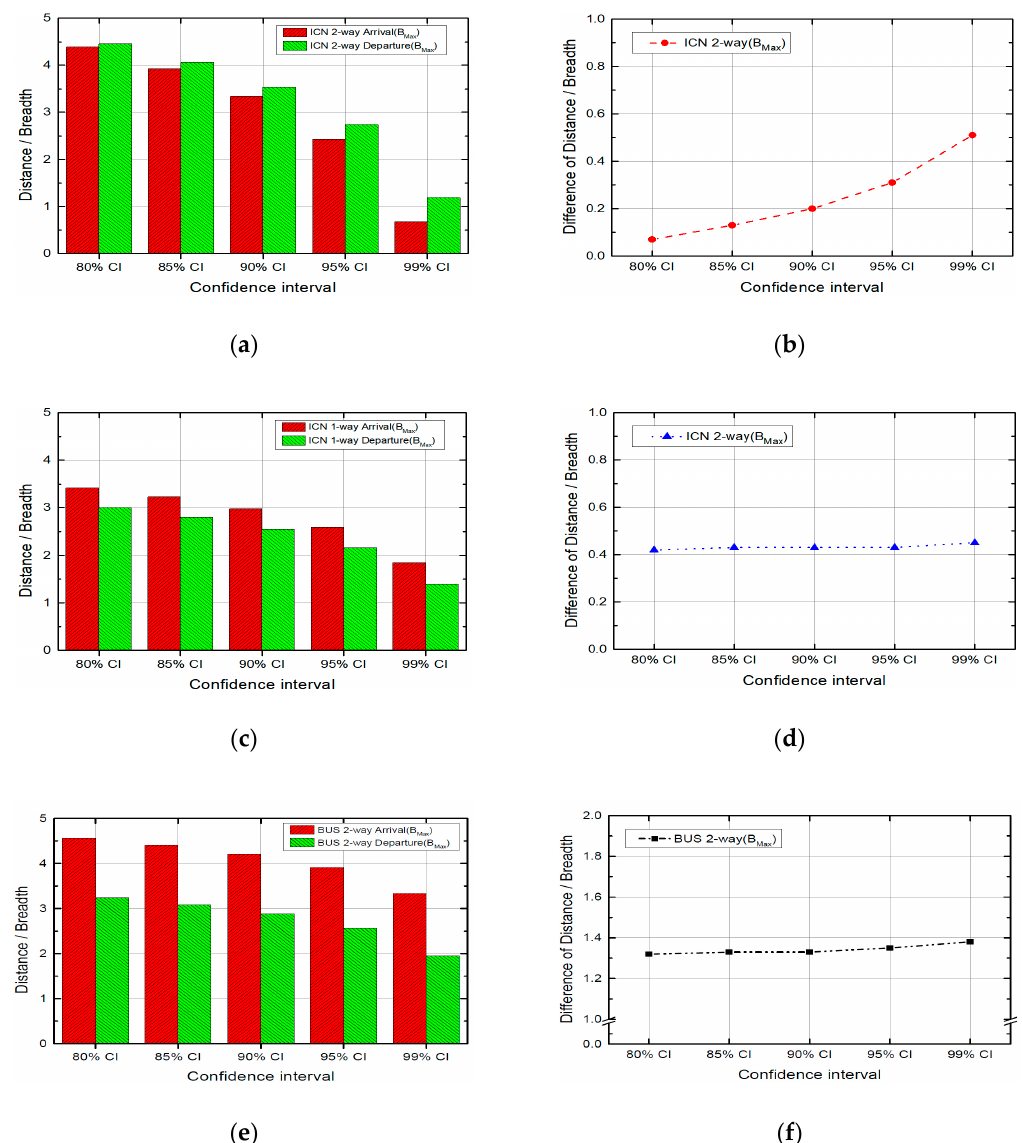
Figure 15. Distance di ff erence divided by ship’s maximum breadth at the Incheon bridge for ( a , b ) 2-way, ( c , d ) 1-way, and ( e , f ) Busan harbor bridge 2-way.